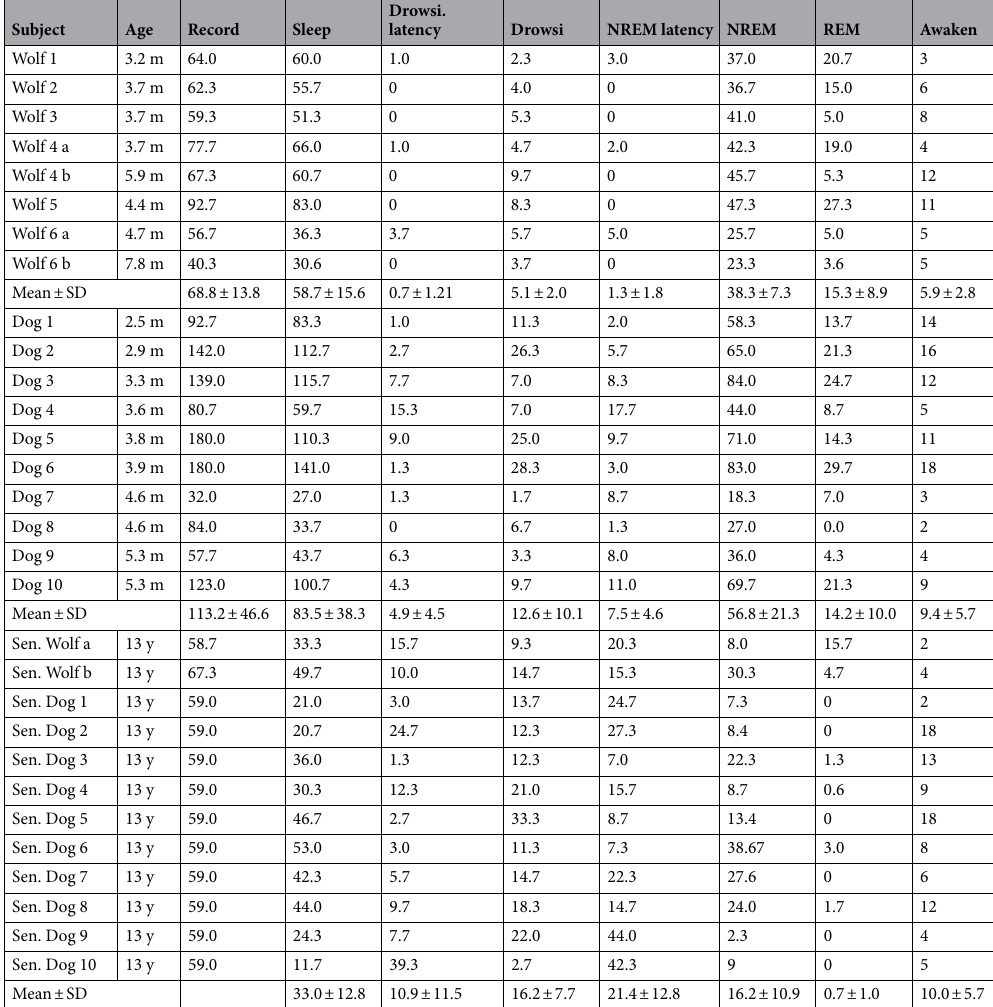
Table 1. Sleep macrostructure variables of individual wolves and dogs. All sleep variables are given in minutes (min). Ages are shown in months (m) and years (y). Sen. indicates Senior, Awaken. indicates the number of awakenings, while the ‘a’ and ‘b’ in the subject’s name indicate the first and second sleep